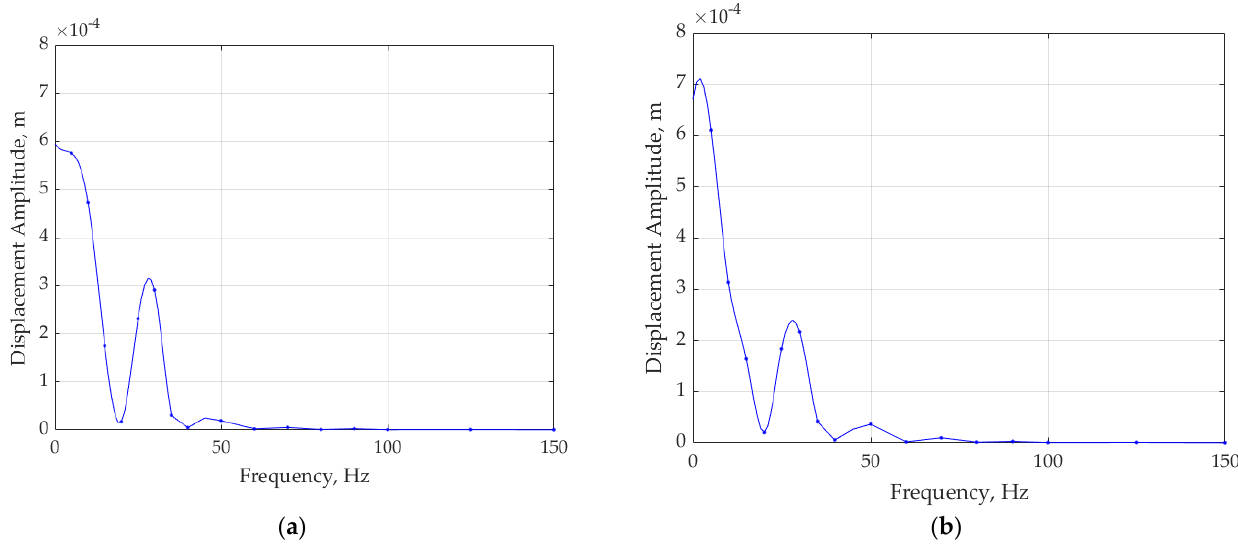
Figure 12. The amplitude as a function of the frequency of measured vibration generator movement for constant input current ( a ) 0.35 A and ( b ) 0.75 A.